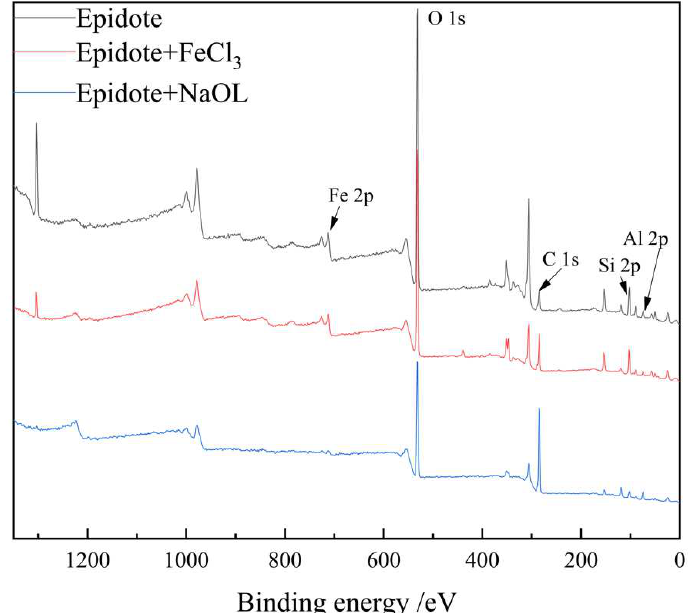
Figure 8. The XPS spectra of feldspar.